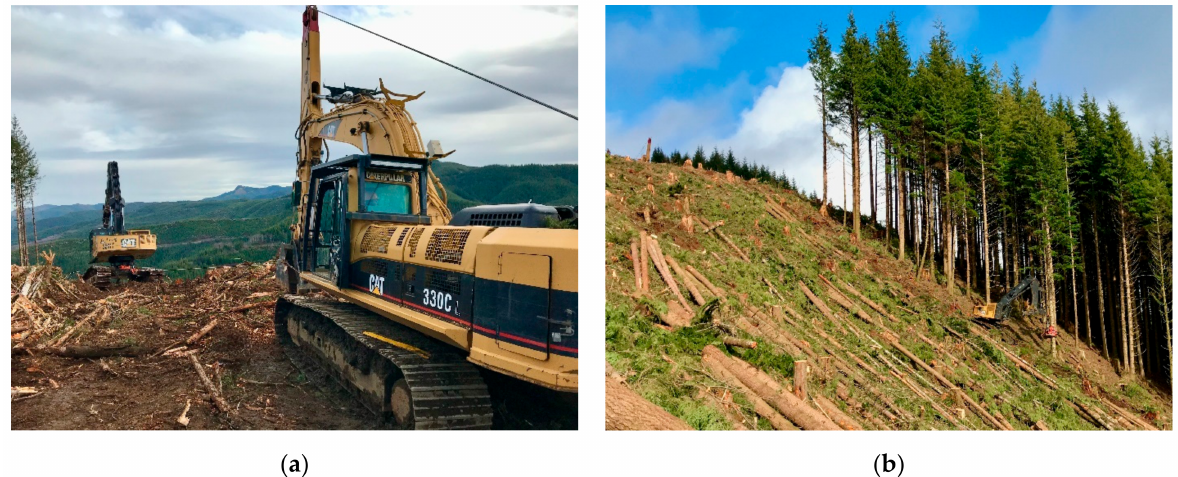
Figure 2. Winch-assist operations based on a Summit Winch Assist system tethering a feller director: ( a ) View from the landing of the initial phase of the winch-assisted operations; ( b ) View of the harvesting operations. Note the anchor machine on top of the hill and the harvesting machine at the bottom